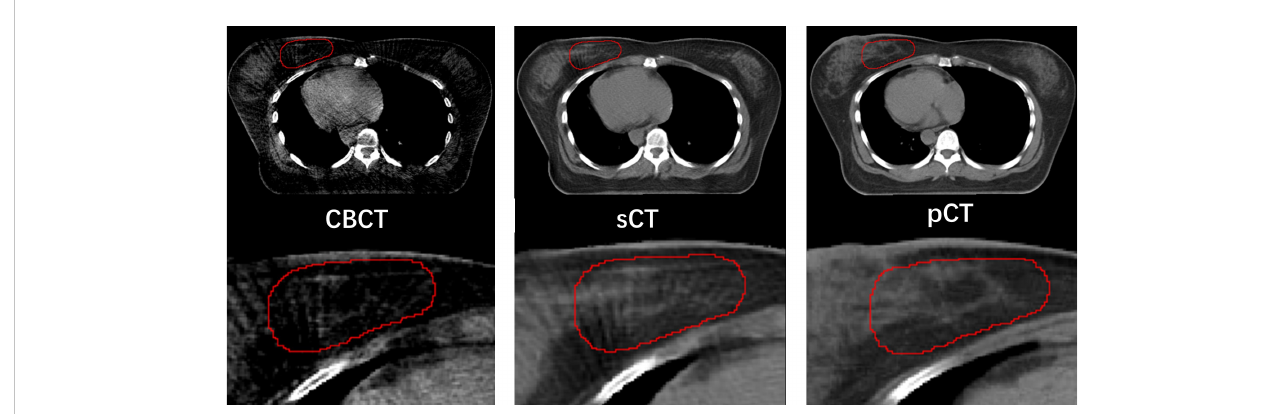
FIGURE 4 Comparison of soft tissue from CBCT, sCT, and pCT images with same window width and location, with tumor bed areas represented by the red contour